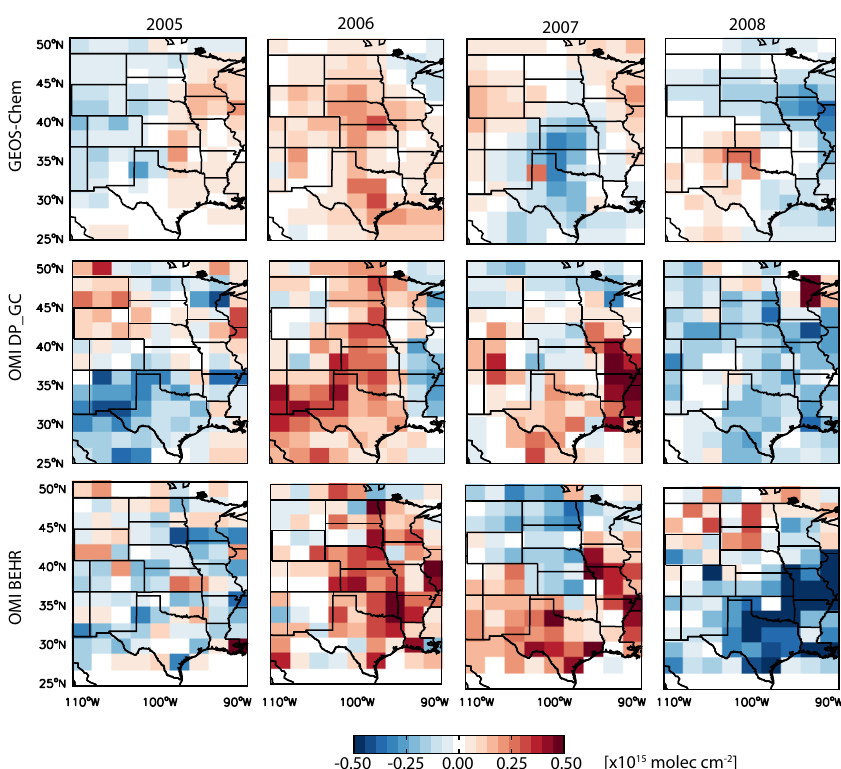
Fig. 6. June mean GEOS-Chem tropospheric NO 2 column density anomalies are compared to mean anomalies for OMI NO 2 from the DP GC retrieval and the BEHR retrieval. Anomalies are calculated as the difference with the June 2005–2008 mean. Color bar saturates at both